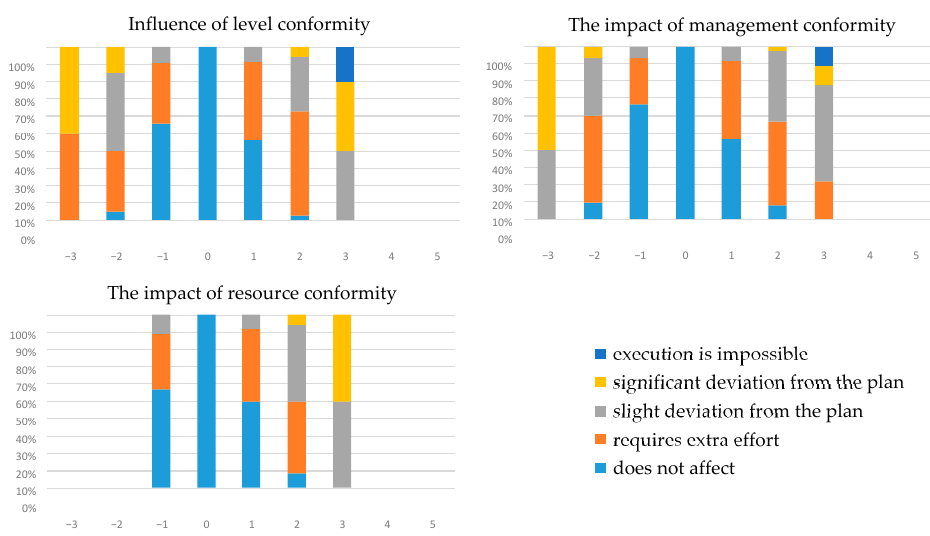
Figure 1. General evaluation of discrepancies by the enterprises’ employees. The generalized results of the subjective evaluation of the deviations impact on the final result are shown in Figure 2.